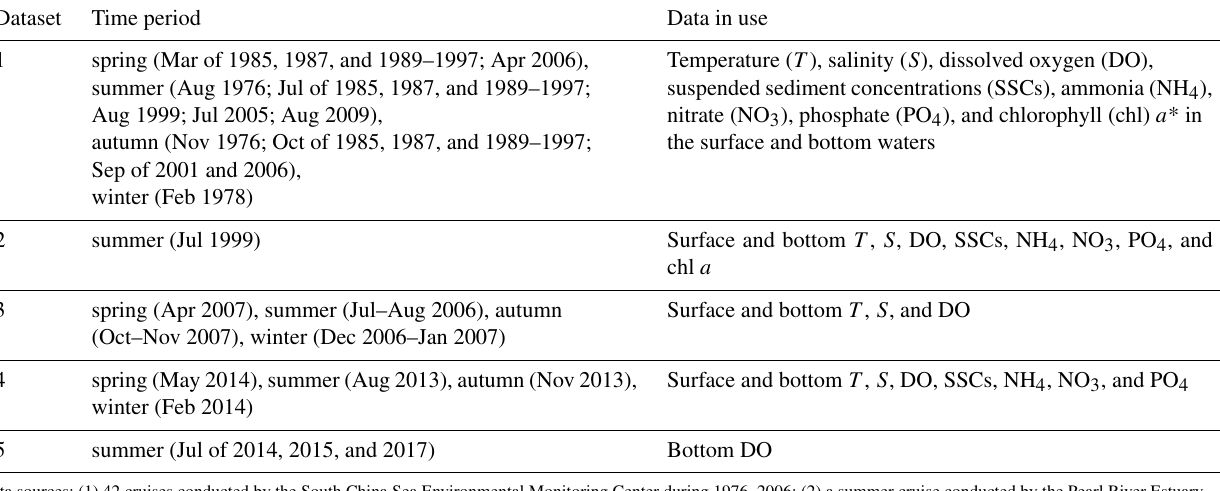
Table 1. A summary of the observational data in the PRE used for analysis.